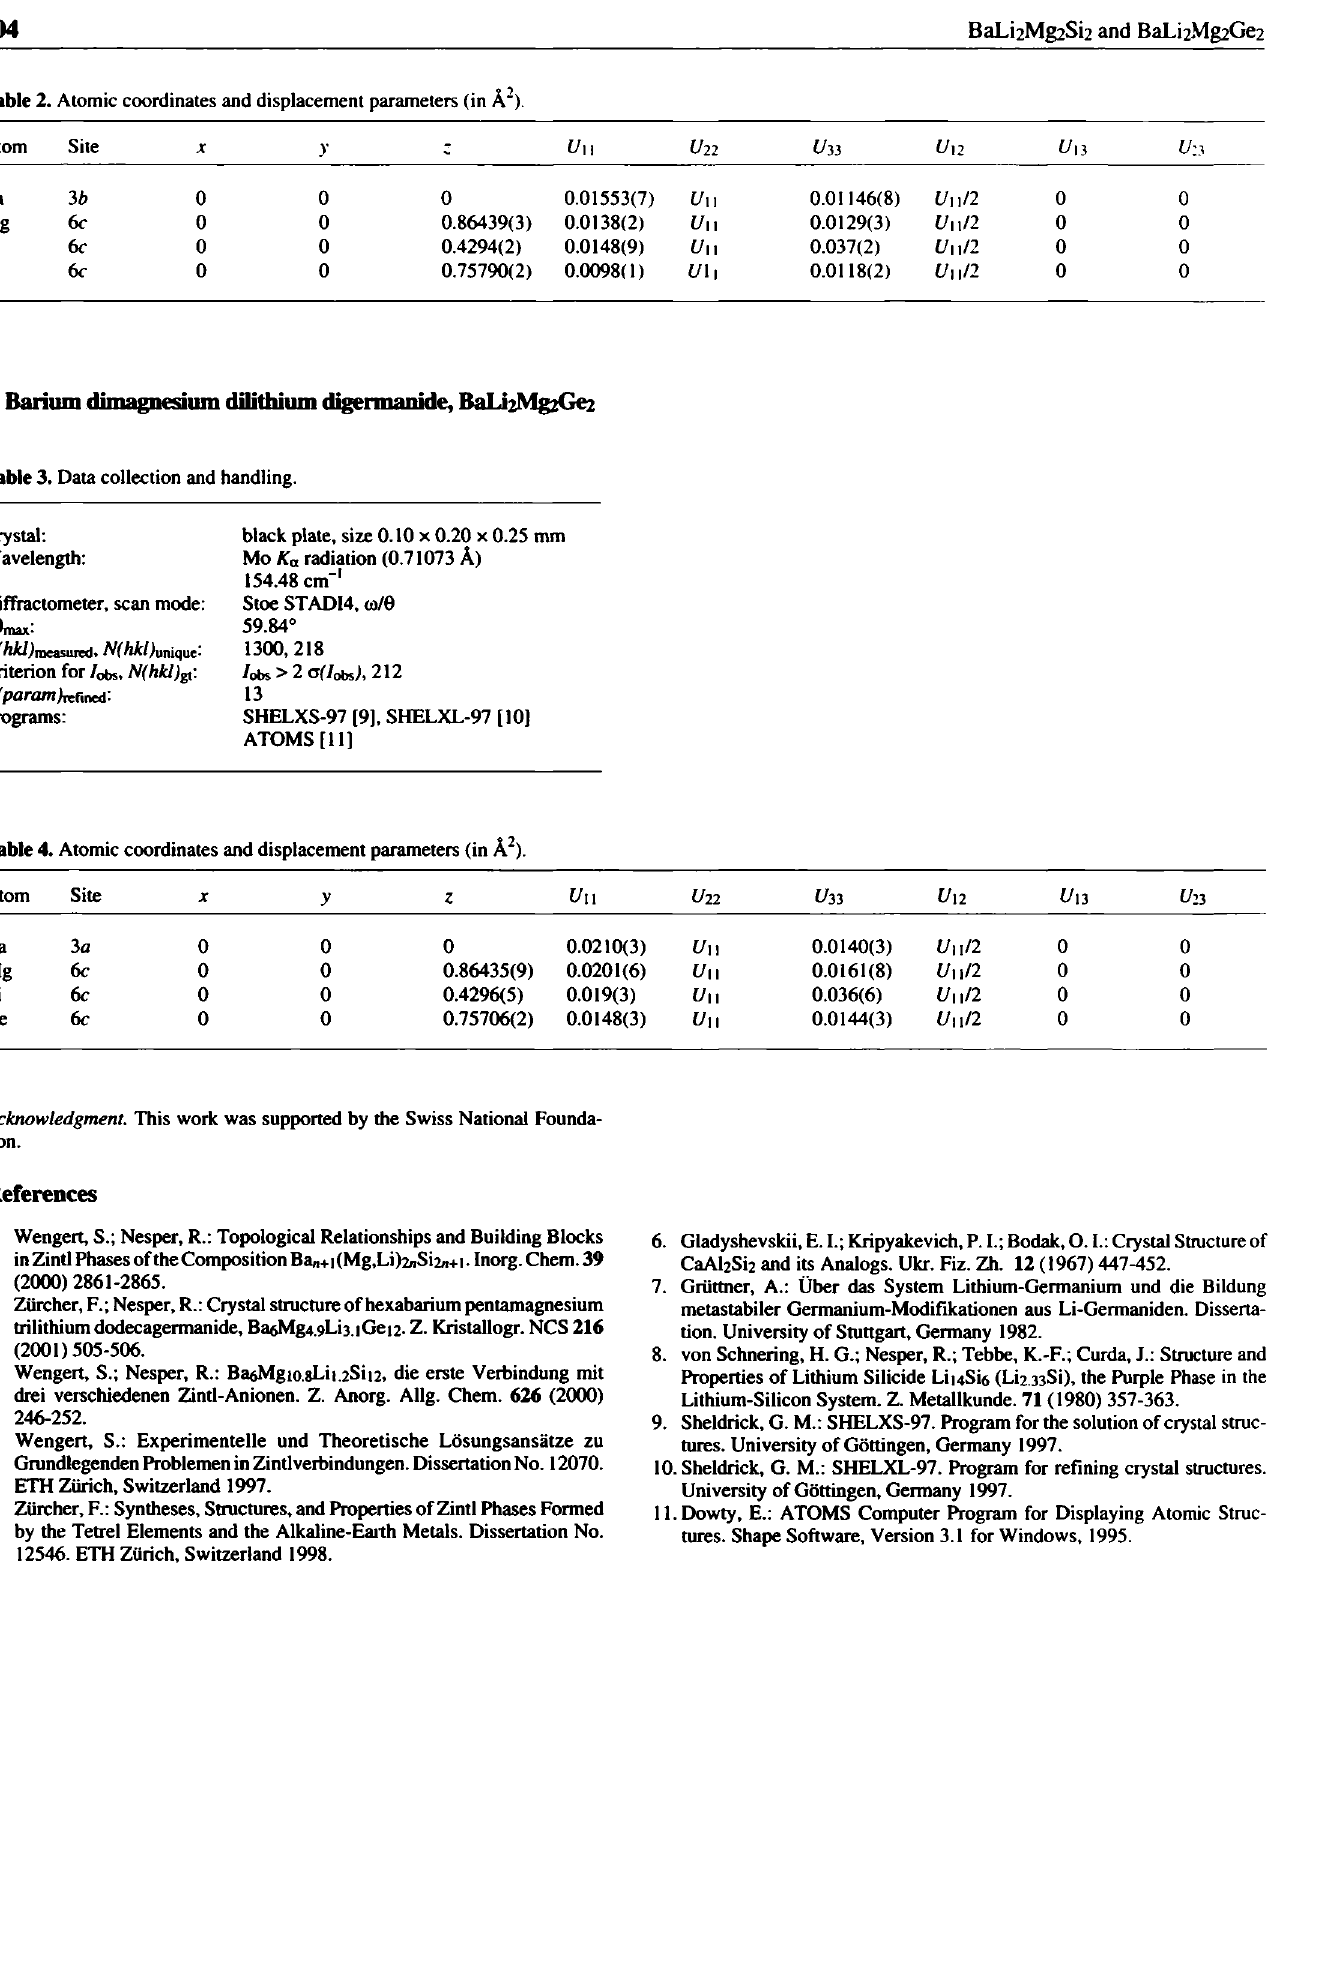
Table 2. Atomic coordinates and displacement parameters (in Ä 2 )